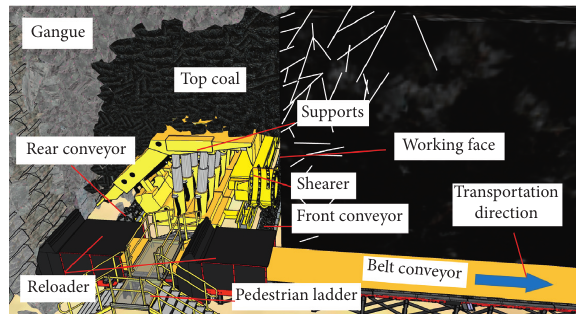
Figure 1: Schematic diagram of an LTCC